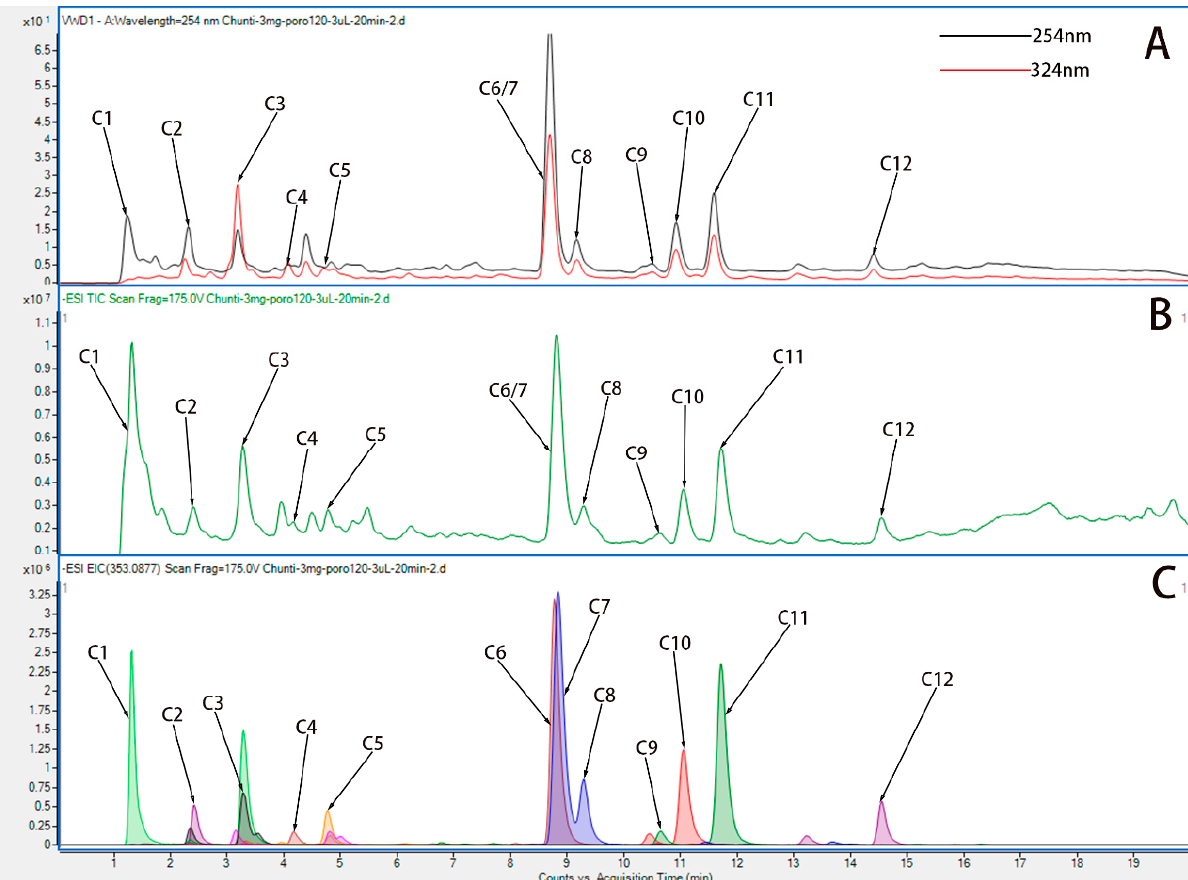
Figure 2. UPLC-Q-TOF chromatograms of water extract of HP. ( A ) Variable wave length ultraviolet detector (VWD) chromatogram of water extract of HP in ESI+ mode. ( B ) Total ion chromatogram (TIC) chromatogram of water extract of HP in ESI+ mode. ( C ) Extracted ion chromatograms (EIC) chromatogram of water extract of HP in ESI+ mode.